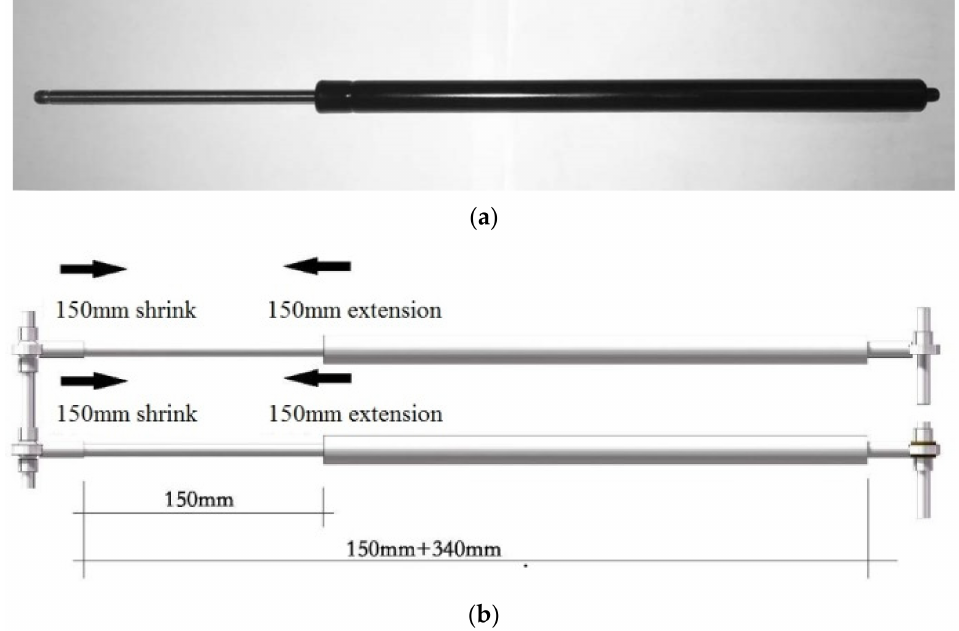
Figure 9. ( a ) Schematic diagram of a single damper and ( b ) schematic diagram of the damper system.